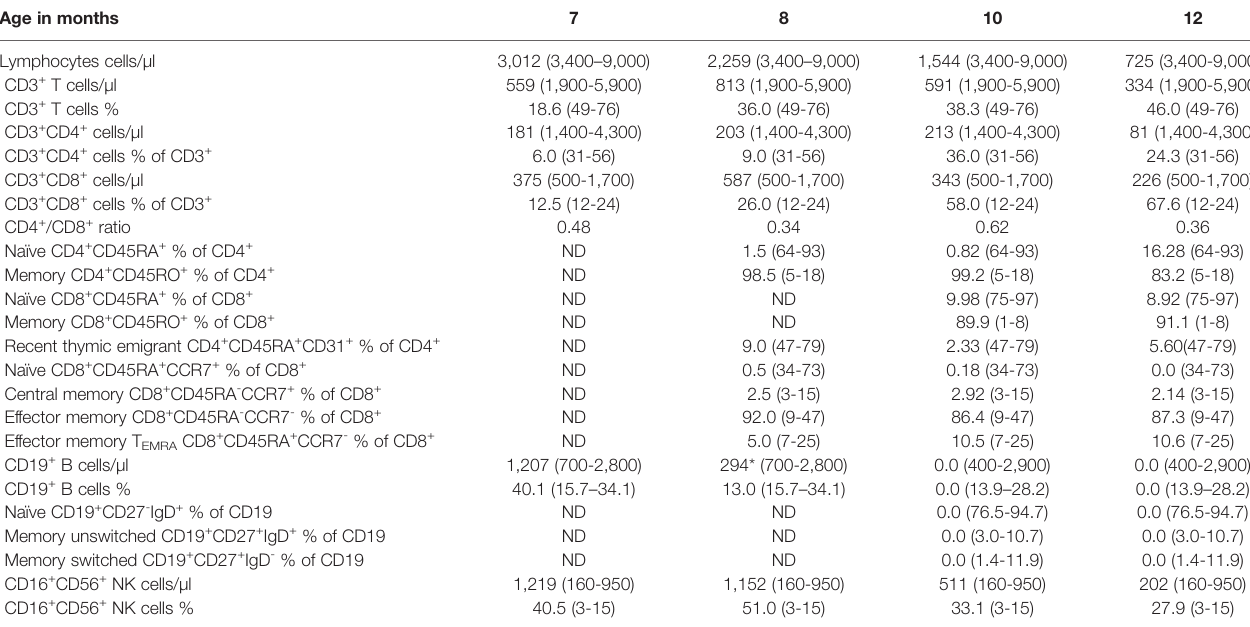
TABLE 1 | Lymphocyte immunophenotype